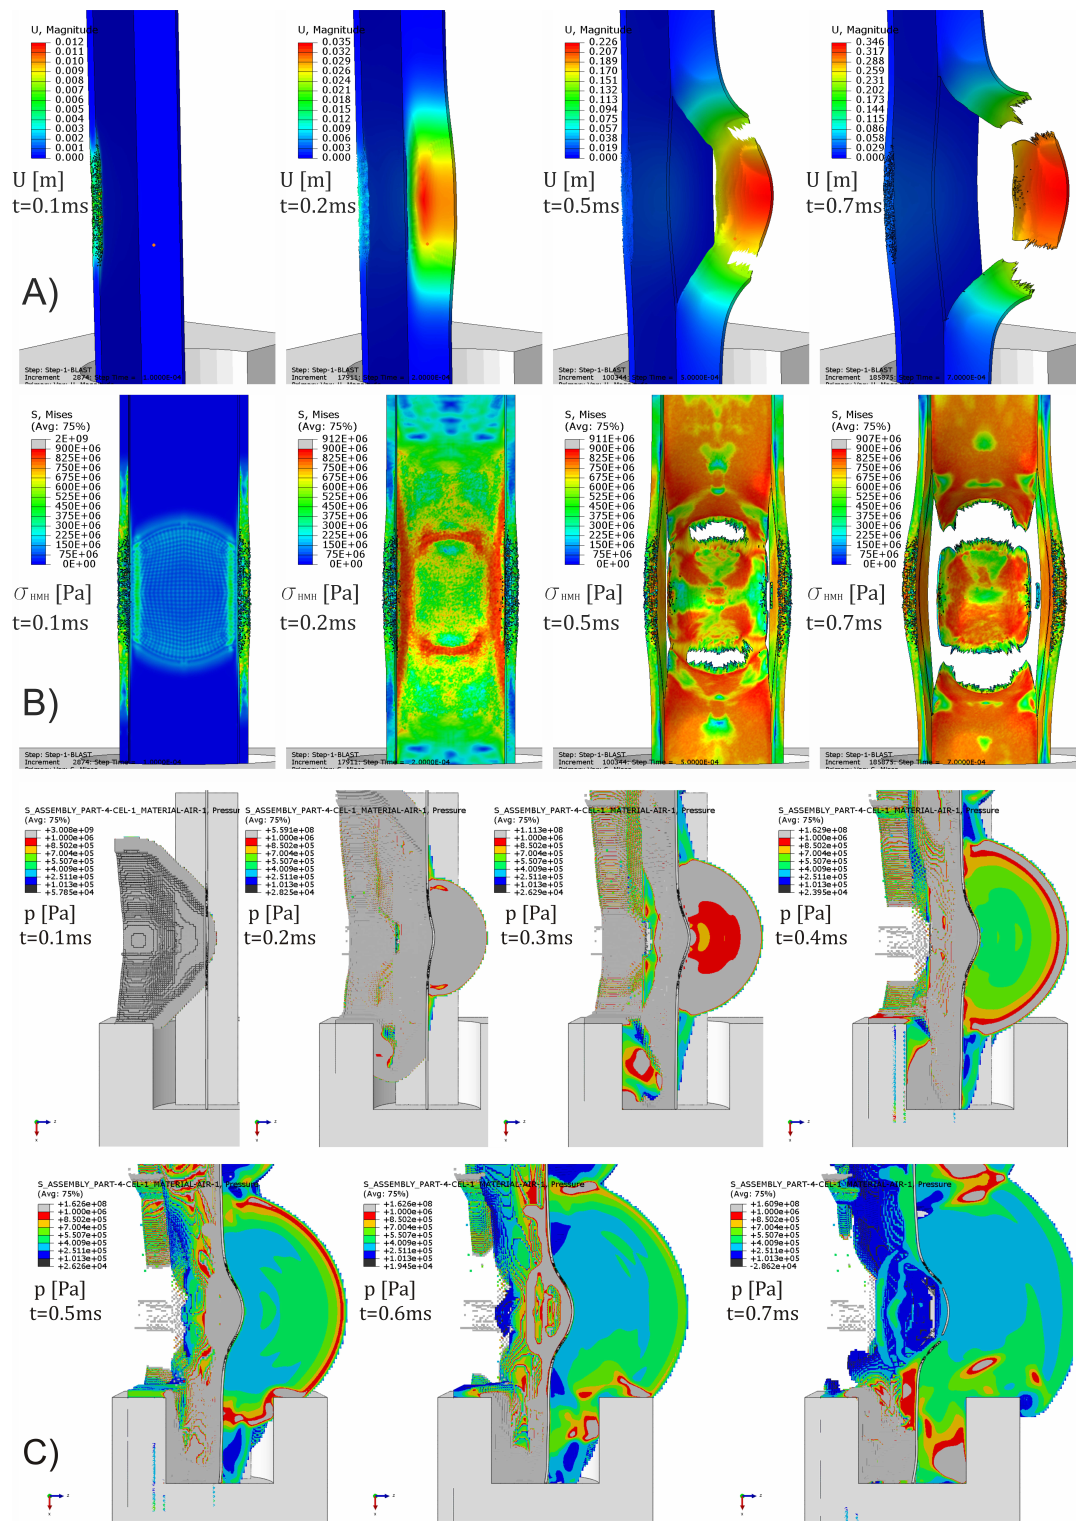
Figure 4. Numerical results: ( A ) Displacement, ( B ) Huber–Mises–Hencky stress, and ( C )